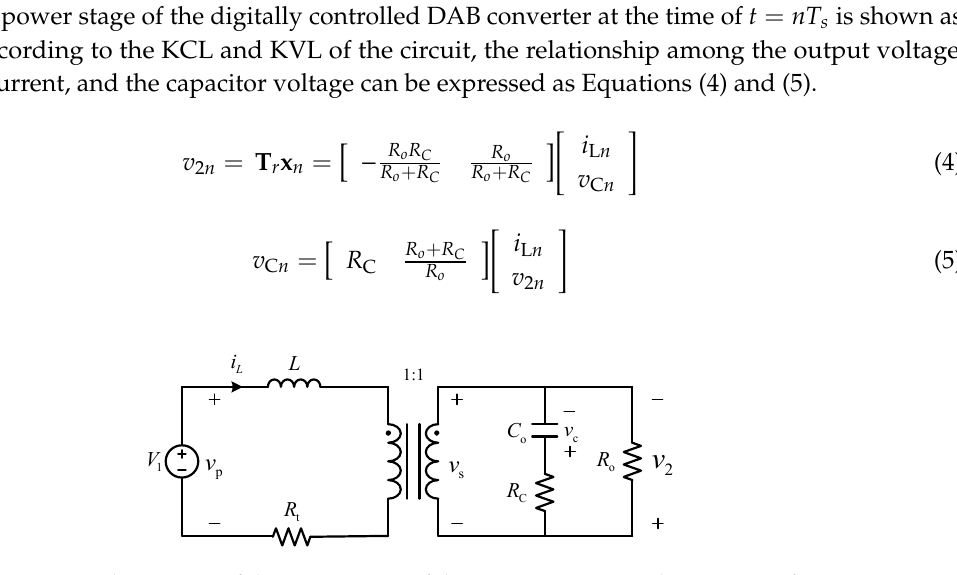
Figure 5. Equivalent circuit of the power stage of the DAB converter at the moment of t = nT s .